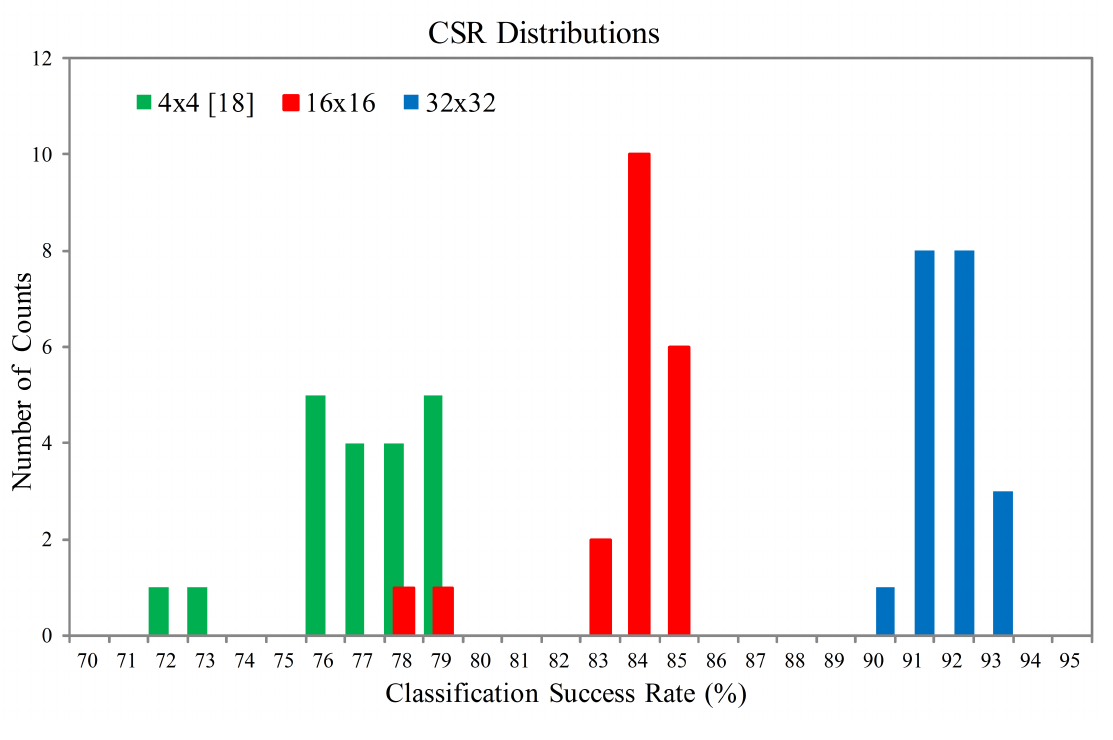
Figure 19. The CSR distributions of the proposed architecture for the texture set shown in Figure